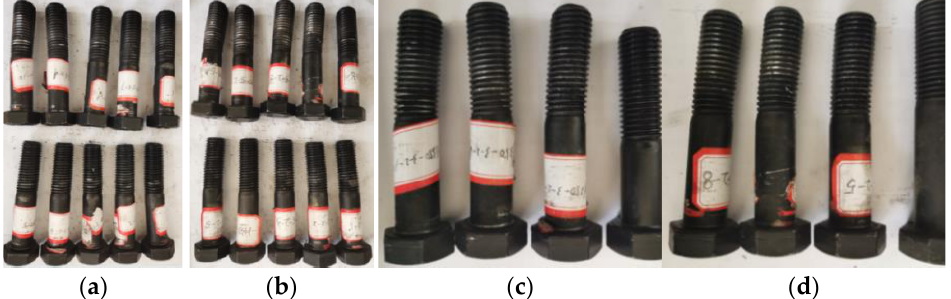
Figure 11. High-stre bolt of specimen: ( a ) H350 − 3 − 2 ( b ) H350 − 4 − 2; ( c ) Bending deformation of No.1, 9 and No.10 ngth bolts of H350 − 3 − 2; ( d ) Bending deformation of No. 5, No. 7 and No. 8 bolts of H350 − 4 − 2.